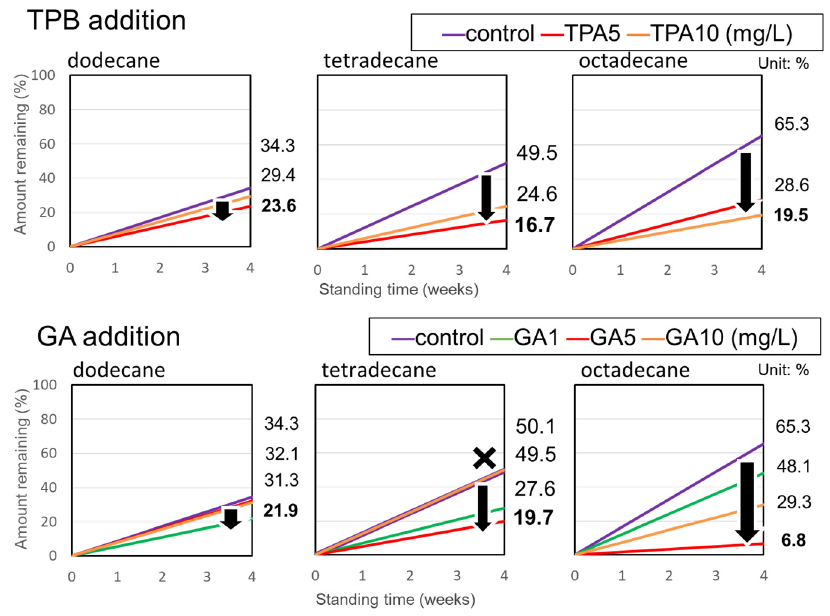
Figure 6. Changes in the amount of myrcenol.